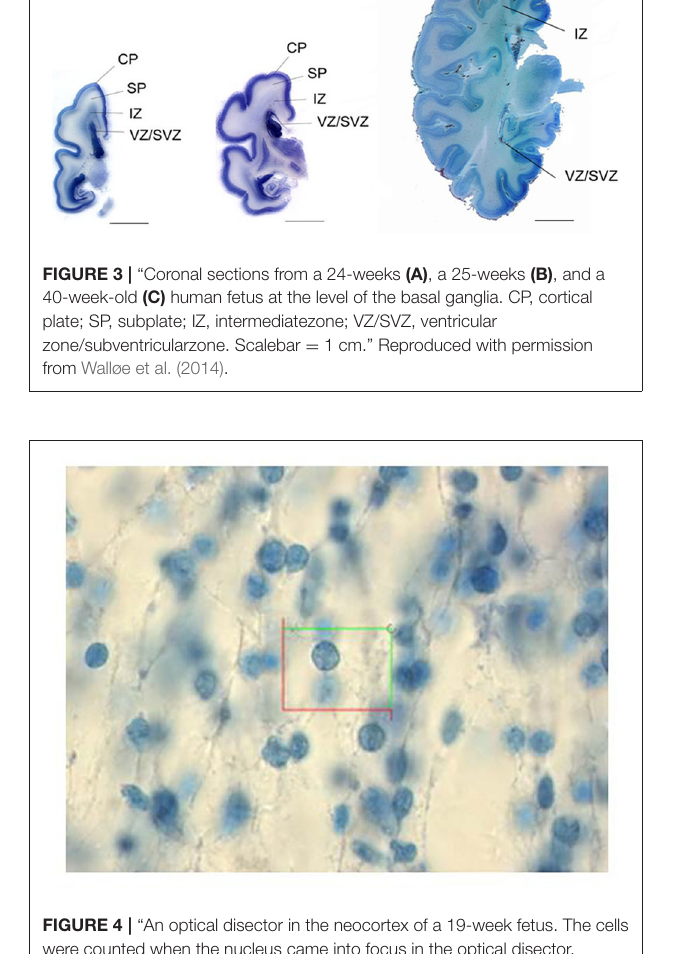
FIGURE 4 | “An optical disector in the neocortex of a 19-week fetus. The cells were counted when the nucleus came into focus in the optical disector. Paraffin, Giemsa—stained section, 40mm thick, magnification 3100x.” Reproduced with permission from Larsen et al.